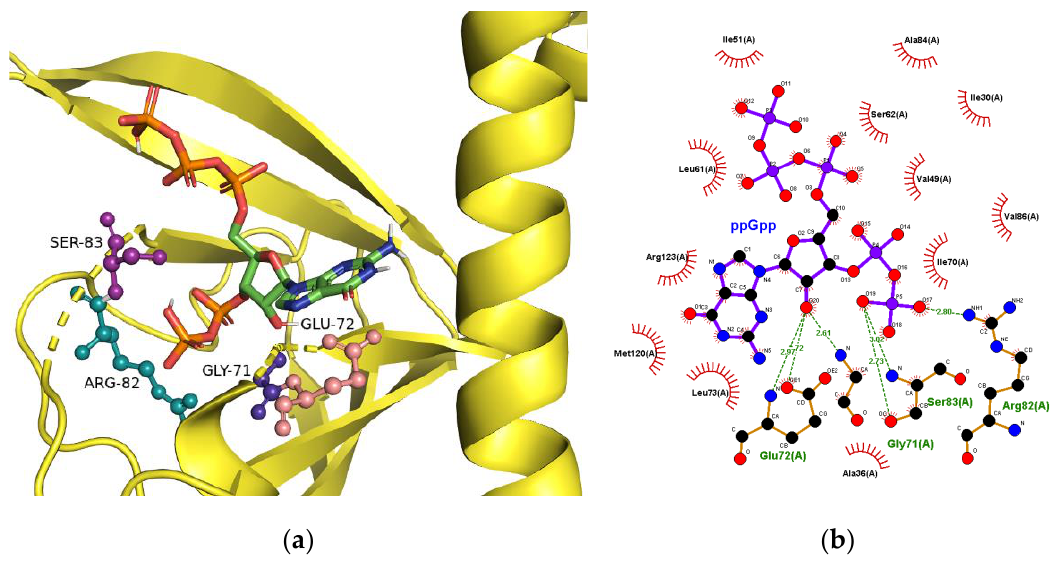
Figure 2. Interaction of ppGpp with CRP. ( a ) The ppGpp-binding site proposed by a molecular modeling study. The interactions between ppGpp and CRP are shown as dotted lines. ( b ) Interacting residues at the binding site. G71, R82, and S83 are commonly interacting amino acid residues in cAMP, cGMP and ppGpp-bound CRP.